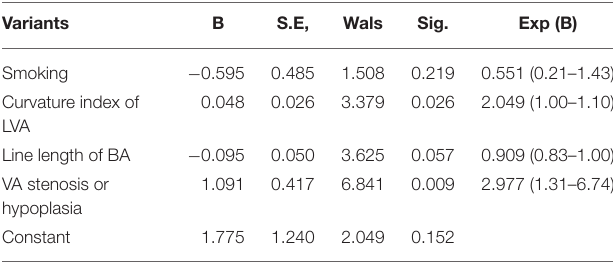
TABLE 5 | Multivariate logistic regression analysis for hypoperfusion in patients with isolated vertigo ( n = 118).